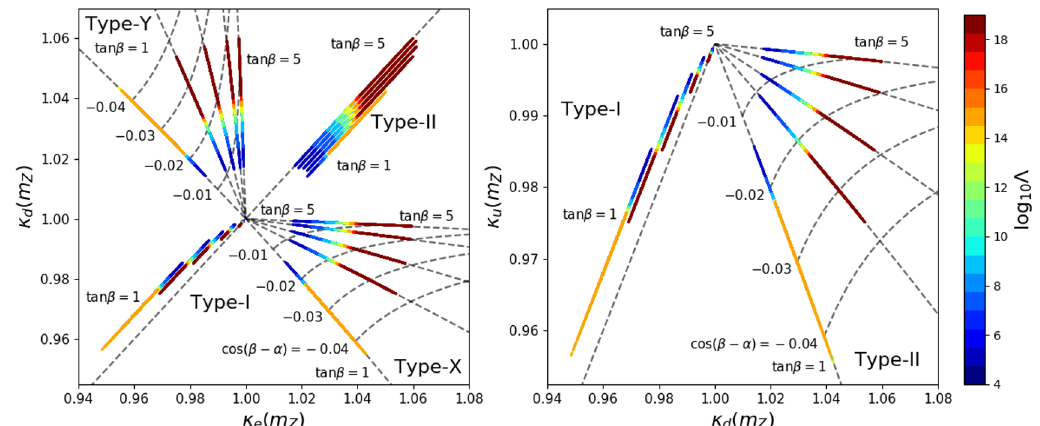
Figure 4 . Predictions on the scaling factors of the SM-like Higgs boson in 2HDMs. The left figure shows the predicted values of κ d and κ e . The right figure shows those of κ u and κ d . tan β = 1 , 1 . 5 , 2 , 3 and 5 with 600GeV ≤ M ≤ 700GeV are chosen as representatives. The points in different colors correspond to the different value of Λ